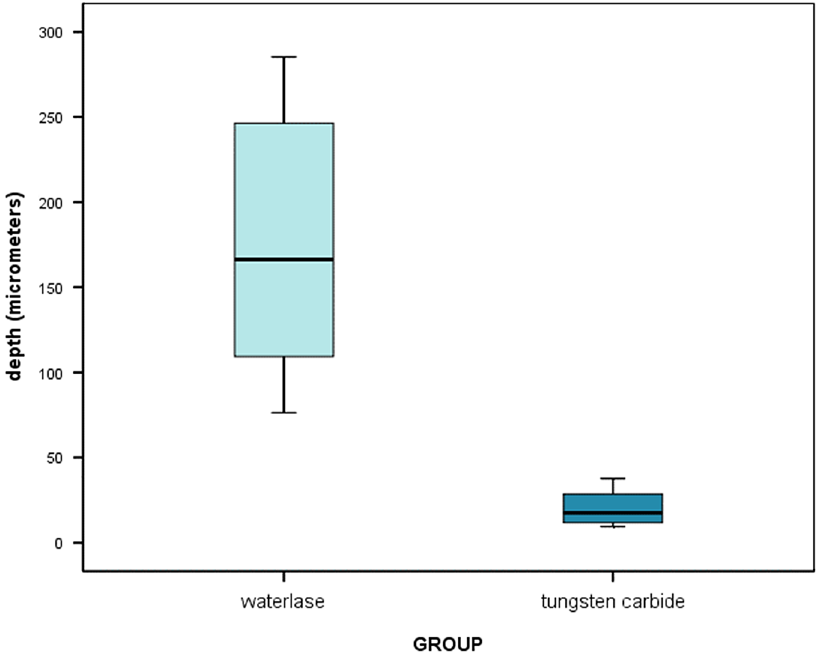
Figure 3. Distribution of depth values.